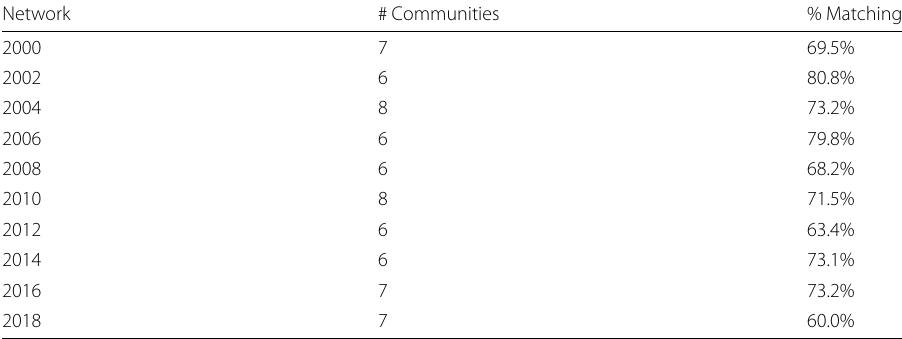
Table 3 Communities and the matching rate to the political ideological position described in Table 2 Network # Communities